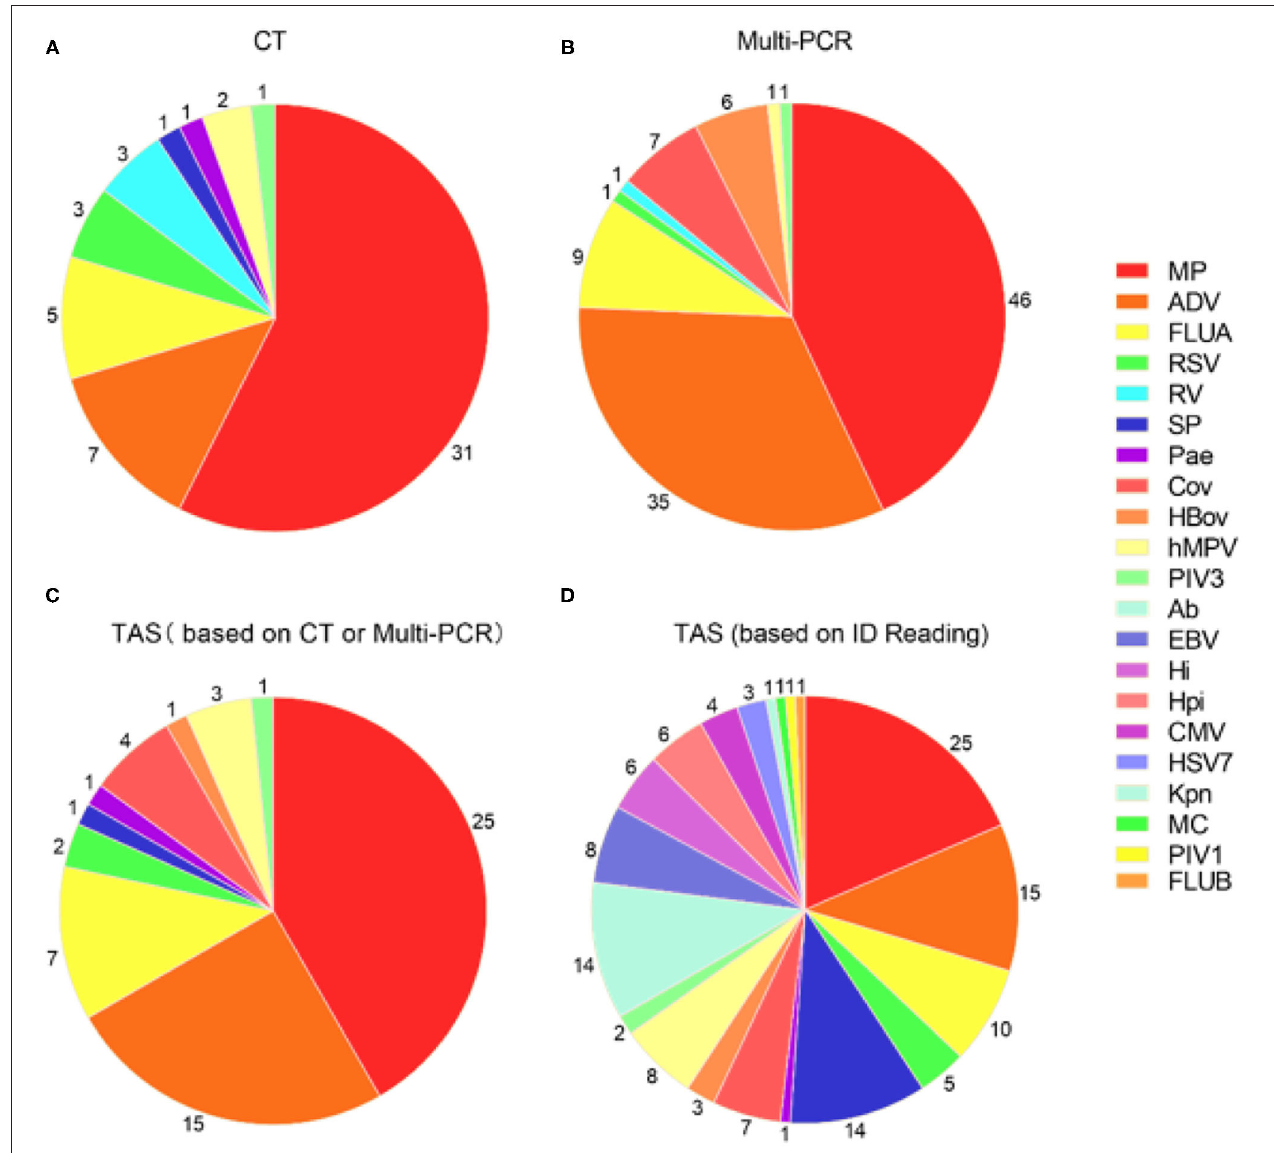
FIGURE 2 | Pathogens detection in 48 samples by three different detection methods. (A) Pathogens detected by CT; (B) Pathogens detected by Multi-PCR; (C) TAS pathogens detection based on CT or Multi-PCR; (D) TAS pathogens detection based on the infectious diseases doctors’ judgment. MP, Mycoplasma pneumoniae ; ADV: Adenovirus; SP, Streptococcus pneumonia ; Ab, Acinetobacter baumannii ; FLUA, Influenza A virus; hMPV, human Metapneumovirus; EBV, Epstein-barr virus; Hi, Haemophilus influenzae ; Hpi, Hemophilus parainfluenzae ; OC43, Coronavirus OC43; RSV, Respiratory syncytial virus; CMV, Cytomegalovirus; HBov, Human bocavirus; HSV7, Human herpesvirus type 7; 229E, Coronavirus 229E; PIV3, Parainfluenza virus type 3; Pae, Pseudomonas aeruginosa ; Kpn, Klebsiella pneumoniae ; MC, Moraxella catarrhalis ; PIV1, Parainfluenza virus type 1; FLUB, Influenza B virus; HKU1, Coronavirus HKU1; NL63, Coronavirus NL63.